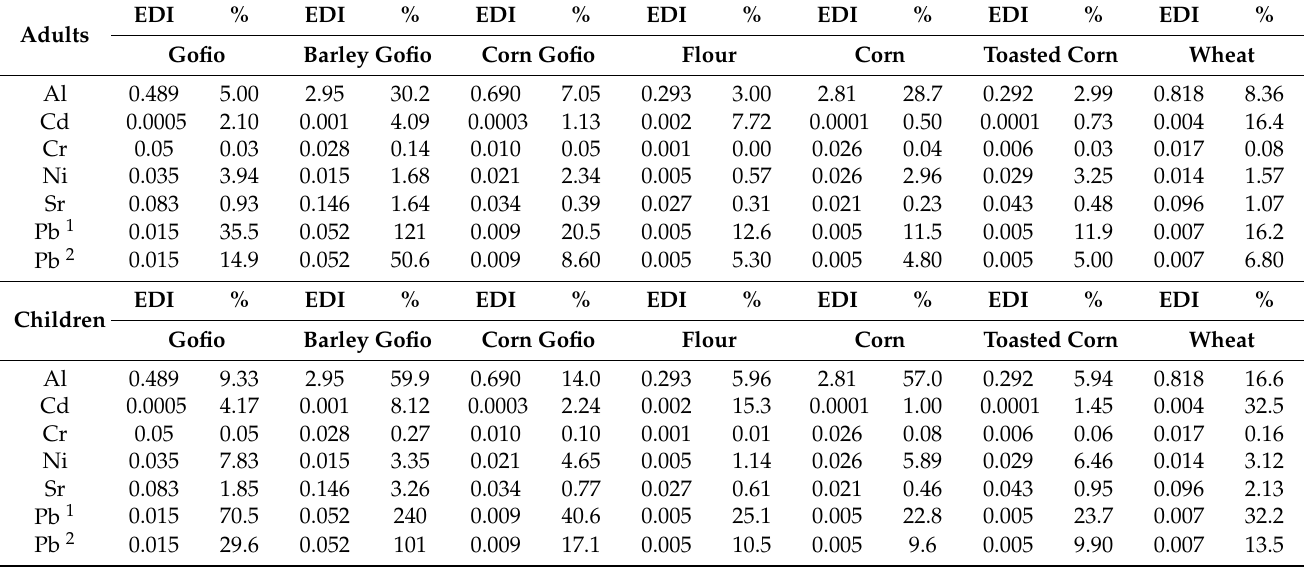
Table 6. Assessment of dietary intake of toxic metals based on the EDI (mg/day) and the contribution percentage (%) for adults and